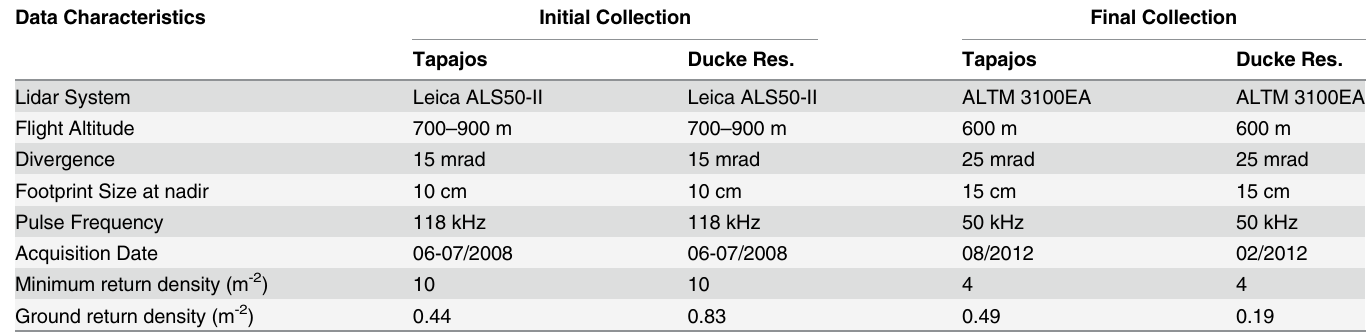
Table 1. Details of airborne lidar data